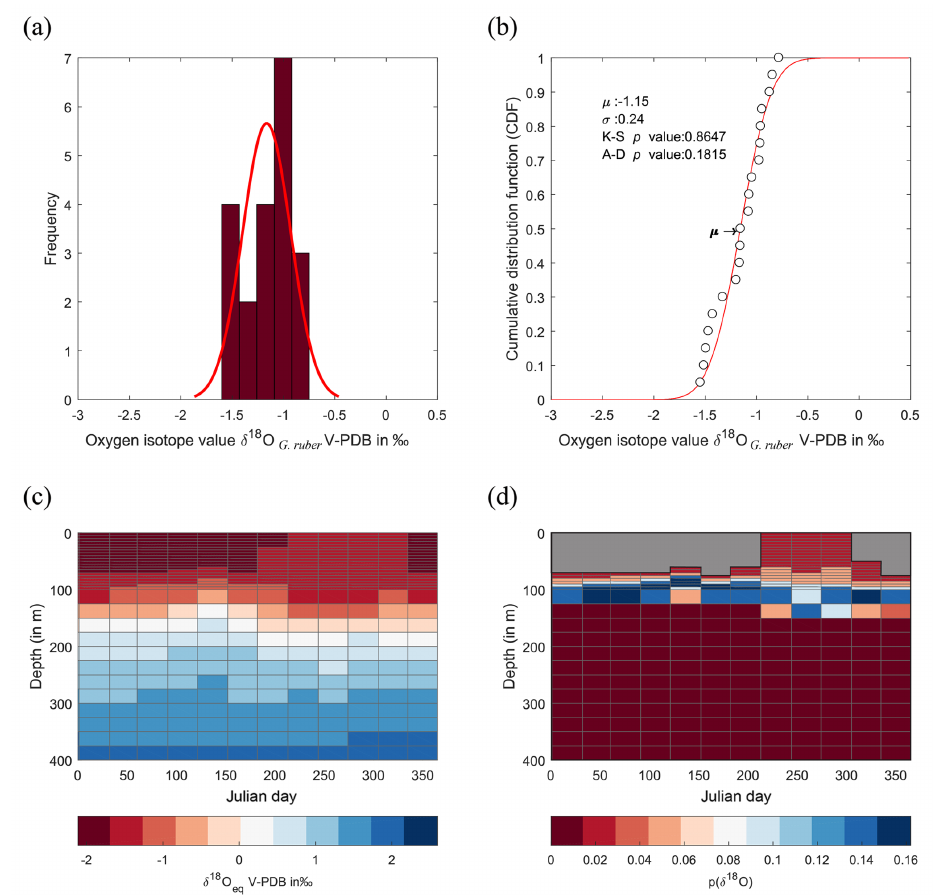
Figure 8. Calculated δ 18 O probability ( p(δ 18 O ) ). (a) Single-specimen isotope measurements for G. ruber , with a fitted normal distribution. (b) These data are used to produce a cumulative distribution function plot (CDF), with statistical output for an Anderson–Darling test, and a Kolmogorov–Smirnov test following data normalization (failure to reject the null hypothesis at the 5% confidence suggests the data are not statistically different from a standard normal distribution, red line in plot). (c) In situ δ 18 O eq values predicted from a regional-specific equation (LeGrande and Schmidt, 2006) and a rearranged form of (Kim and O’Neil, 1997) with WOA13 temperature and salinity values as input values. (d) Resultant calculated p(δ 18 O ) ; the probability of each discrete δ 18 O is denoted as p(δ 18 O ) mapped upon the δ 18 O eq WOA13 values. The grey region represents the area between 0m and the first probable depth that may have become overprinted during depth